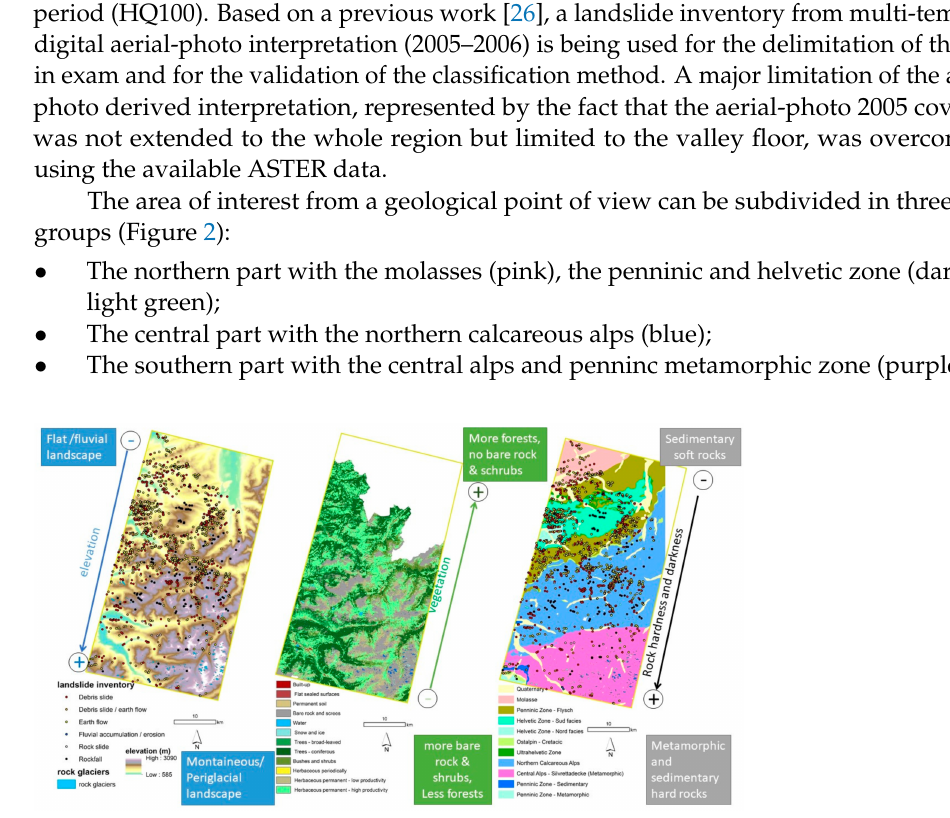
Figure 2. Correlation of elevation-geomorphology, vegetation-land cover map and lithology with the landslide inventory used for the validation of the remote sensing